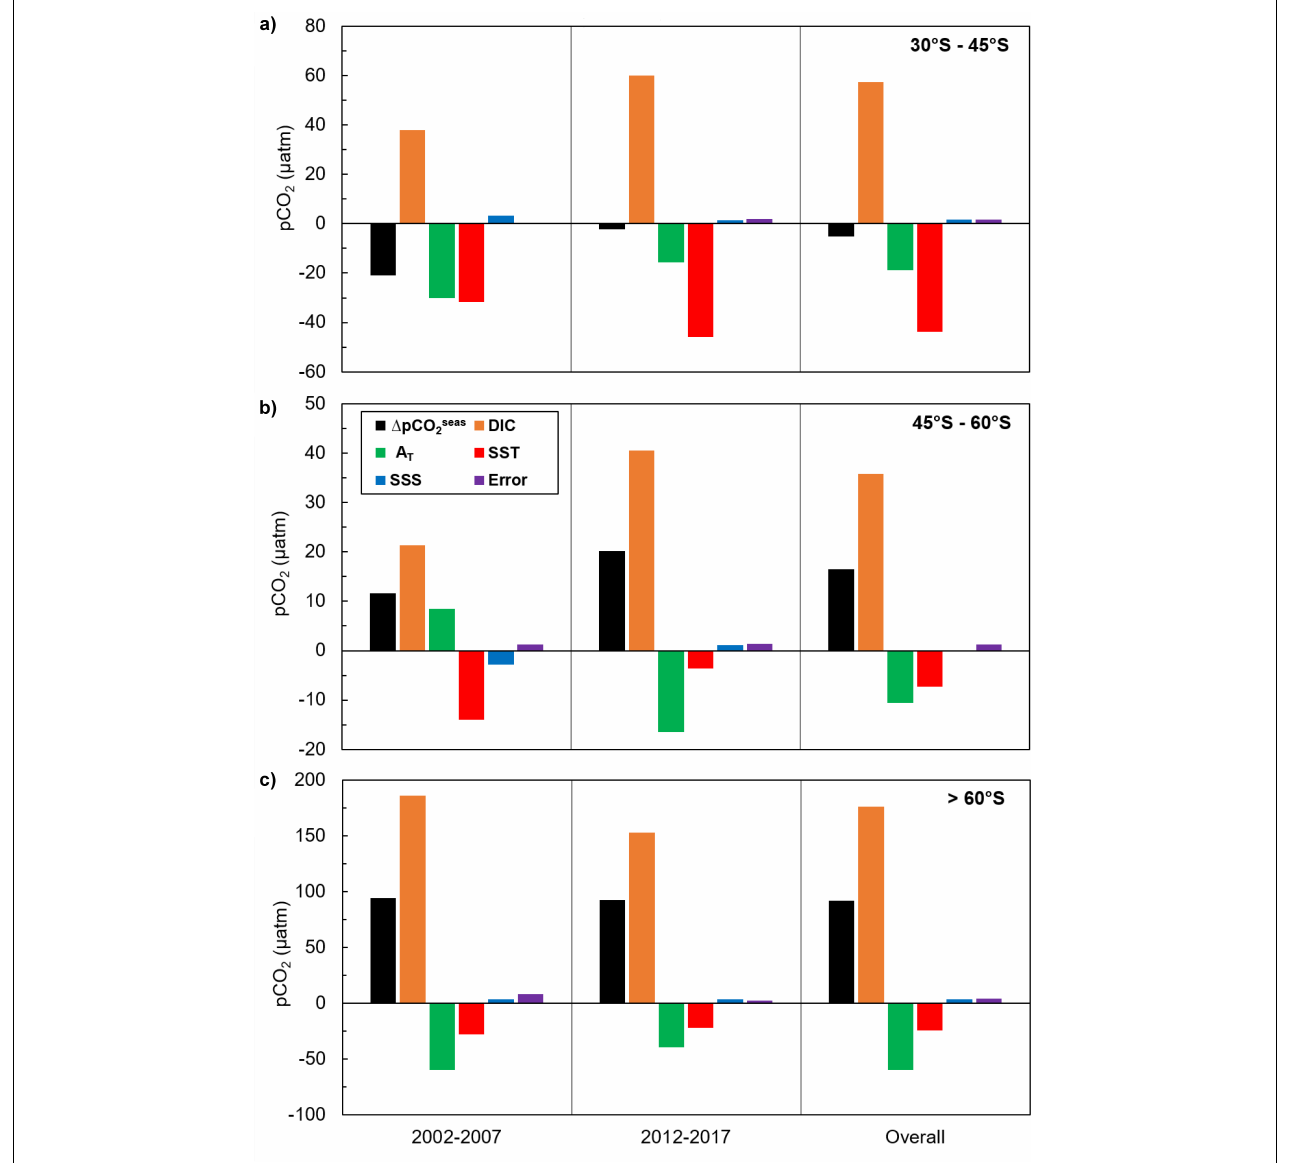
FIGURE 6 | Effects of seasonal variation in DIC, total alkalinity (A T ), temperature (SST) and salinity (SSS) on the seasonal variation in seawater p CO 2 for each latitudinal zone of the Southern Ocean for 2002–2007 and 2012–2017: (a) 30–45 ◦ S, (b) 45–60 ◦ S, and (c) > 60 ◦ S. The seasonal variation in each parameter is calculated as the difference between the winter (JAS) mean value and the summer (JFM) mean value. The unit of all drivers is the same as the unit of p CO 2 ( µ atm), and their magnitudes represent their influence on seasonal p CO 2 changes ( (cid:49) p CO 2seas ), from summer to winter. Positive values indicate that an increase in the parameter led to an increase in p CO 2 ; negative values indicate that a decrease in the parameter led to a decrease in p CO 2 . The only exception to this is alkalinity because an increase in alkalinity leads to a decrease in p CO 2 and vice versa. The error bars (purple) show the difference in seasonal variation between the sum of all drivers and p CO 2 , indicating the extent to which the decomposition of p CO 2 into its drivers differs from the actual seasonal variation in p CO 2 ( (cid:49) p CO 2seas